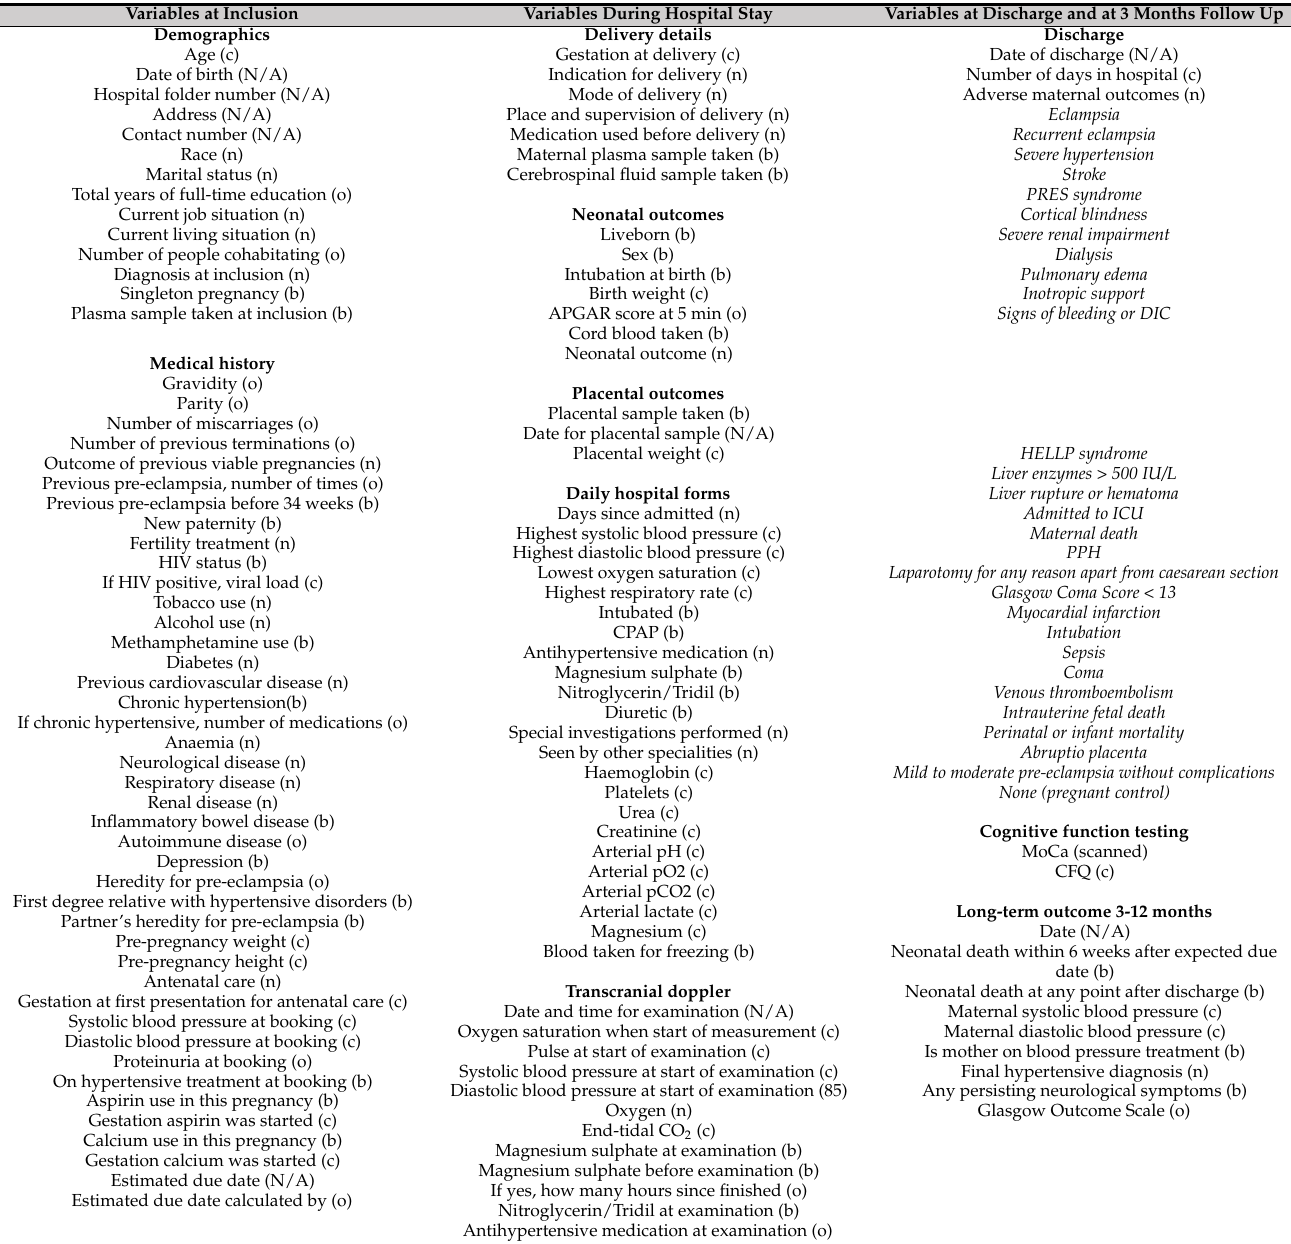
Table 1. Clinical information collected in the database